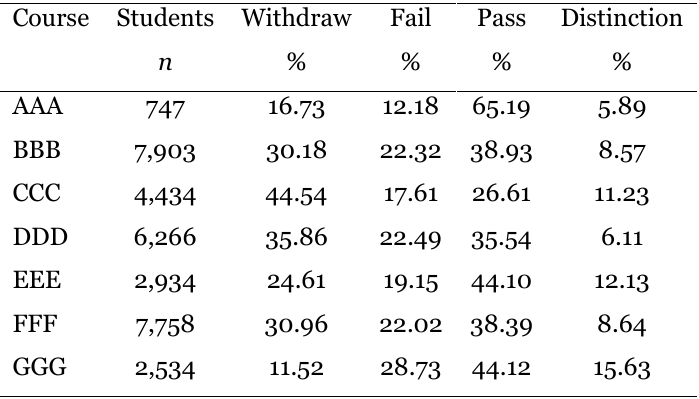
Enrolment and Academic Results (Per-Course